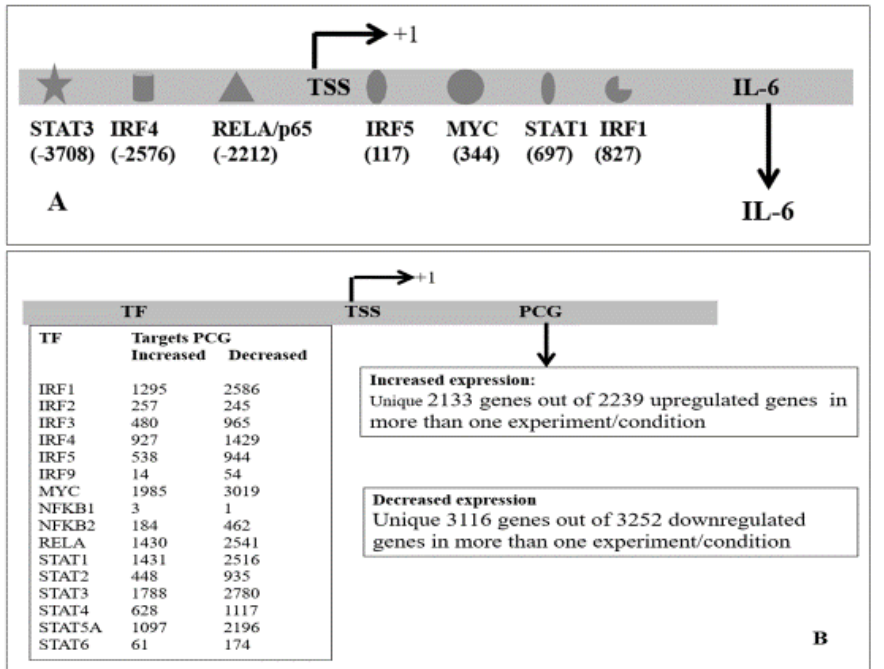
Figure 9. ( A ): Binding of different TFs at the putative promoter of IL-6 as obtained from ChIPBase. IRF1 (positions 994, 827, 713), IRF4 ( − 2576, − 3246), IRF5 (117), MYC (878, 805, 738, 678, 676, 660, 646, 643, 636, 632, 613, 580, 494, 477, 344, − 94, − 2476), RELA (705, − 2212), STAT1 (697, 490), STAT3 (987, 554, − 3708) could bind to the putative promoter ( − 5Kb to +1Kb of the TSS). Only one of the binding sites of a TF is shown. Summary of the result obtained for all 16 TFs and 2133 upregulated genes and 3116 downregulated genes, where binding of at least one of 16 TFs was obtained is shown in ( B ). Detail result is shown in the Tables S28 and